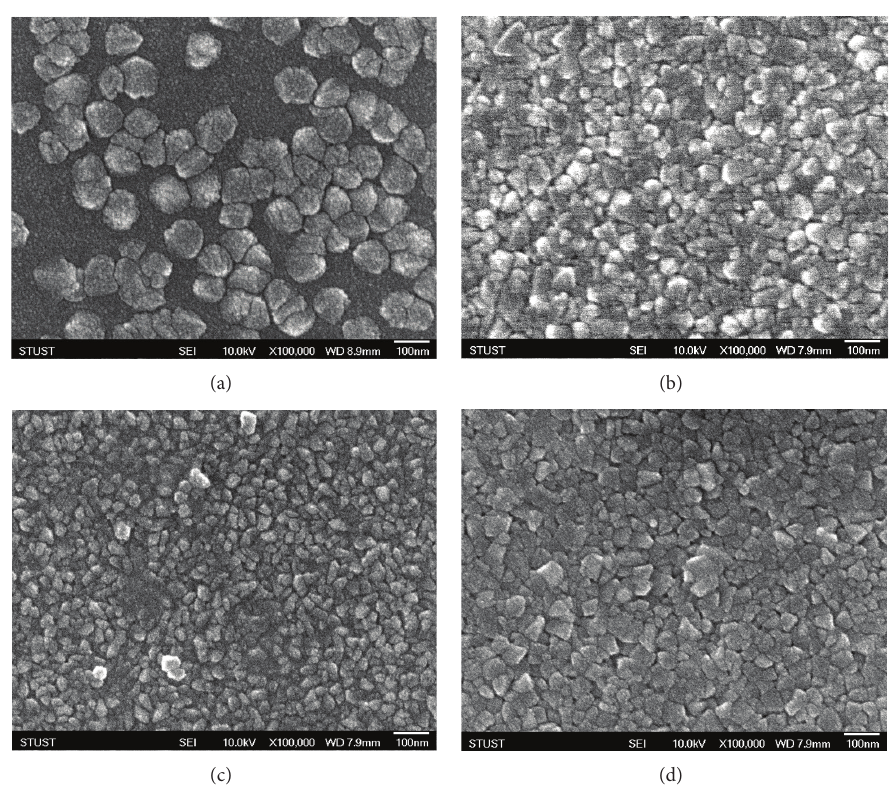
Figure 2: SEM images of TiO 2 thin films at different growth temperatures: (a) 200 ∘ C, (b) 300 ∘ C, (c) 400 ∘ C, and (d) 500 ∘